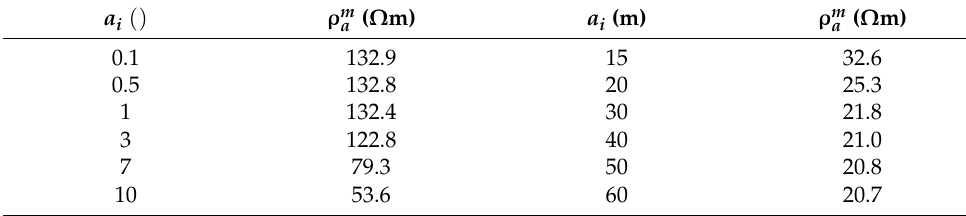
Table 3. Apparent soil resistivity. Table 2. Parameters of the two-layer structure.